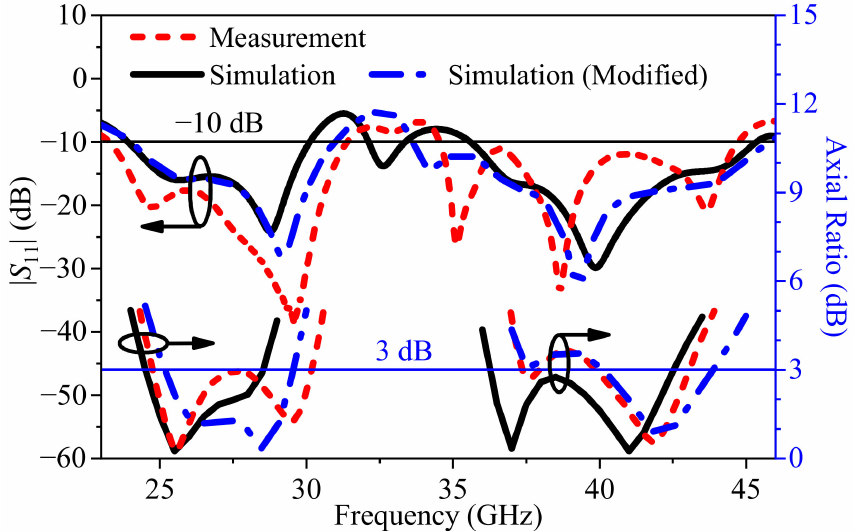
Figure 10. Simulated and measured reflection coefficients and broadside ARs of the proposed dual-band CP